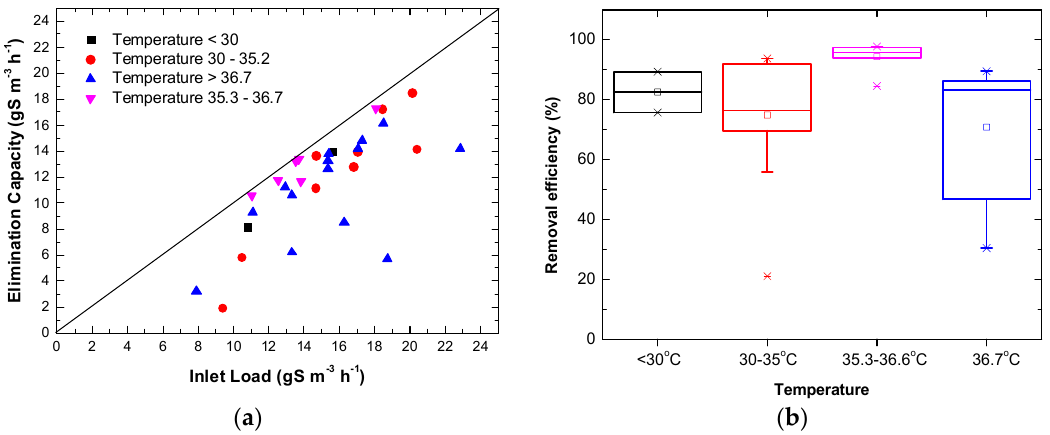
Figure 6. Effect of temperature on the ( a ) elimination capacity and ( b ) removal efficiency. The data include inter-quartile deviations and medians (larger box), ( □ ) average values, (x) outliers and (-) maximum (upper whisker) and minimum (lower whisker) limits of non-discrepant values.